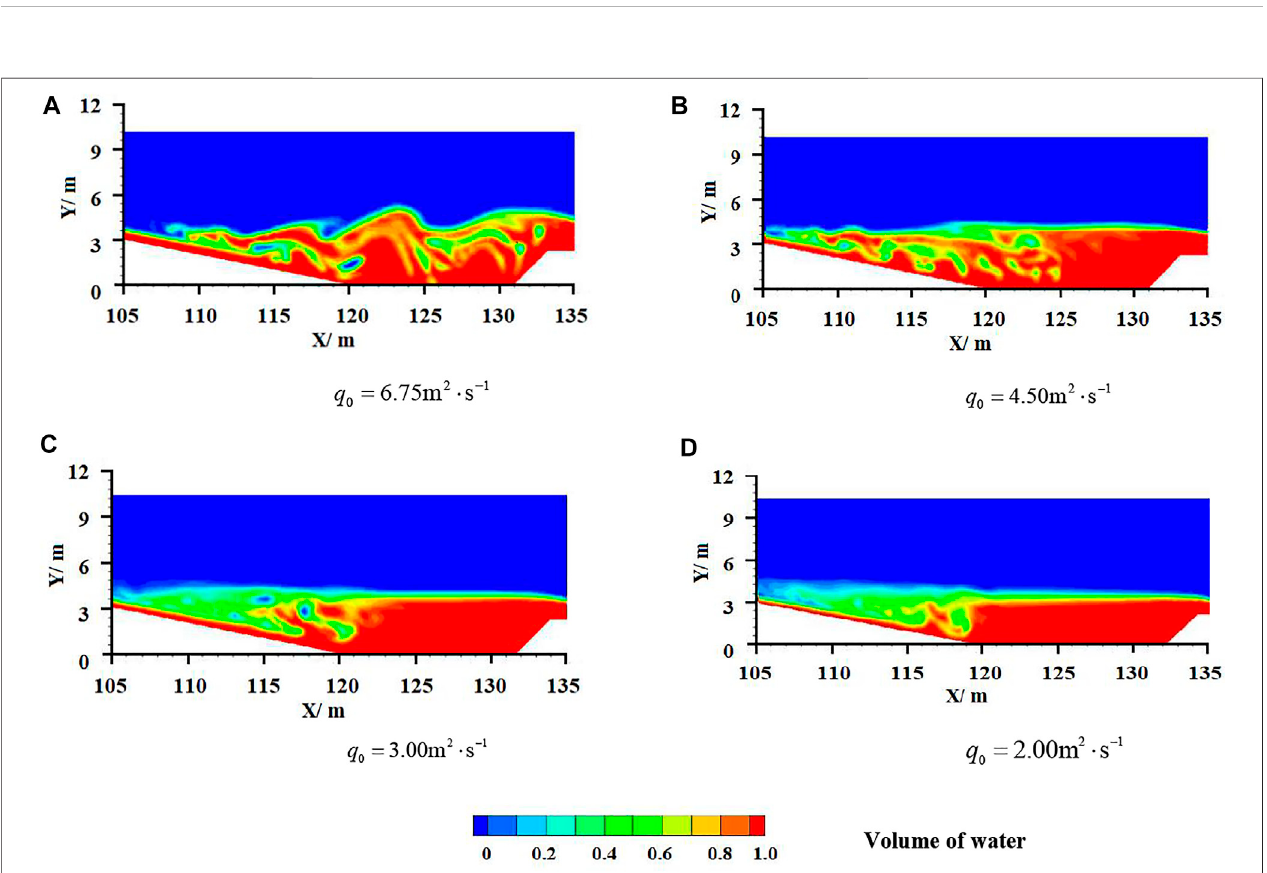
FIGURE 5 | Nephogram of water – air phase fl ow in the slope (A – D) of different inlet unit width fl ows.